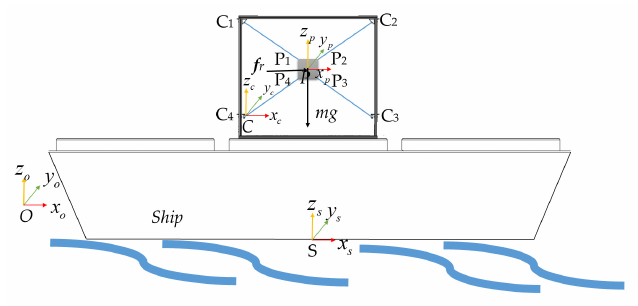
Figure 3. Reference frames and dynamic parameters of CDPDR.